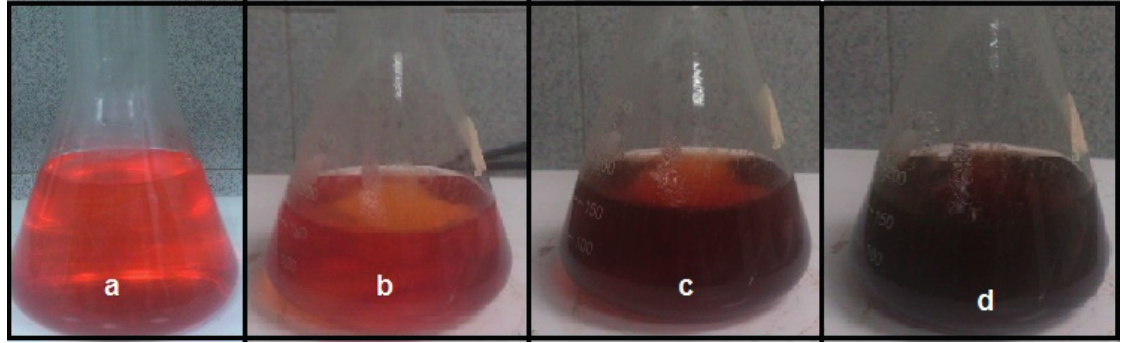
Figure 1. Synthesis of silver nanoparticles (Ag-NPs) using aqueous extract of sumac : ( a ) aqueous extract of sumac ; ( b ) initial point of time; ( c ) mid-point of time and ( d ) final point of